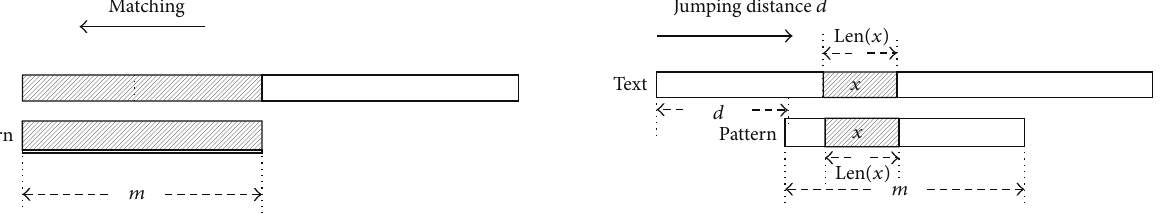
Figure 3: Success of perfect matching of text bit string.